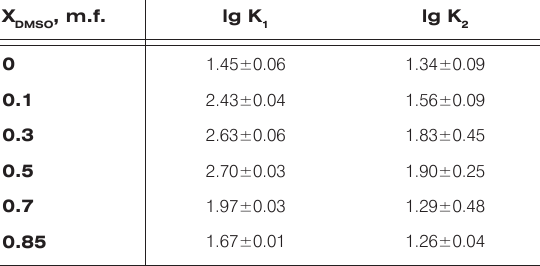
) and bis (K ) nicotinamide 1 2